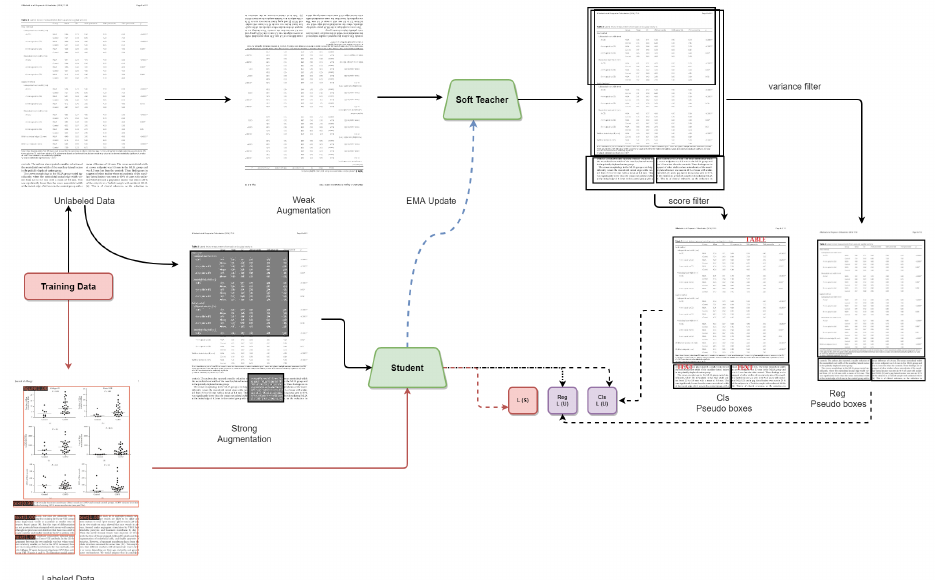
Figure 3. The image represents the Soft Teacher process: (1) The training data are divided into labeled and unlabeled data. (2) Weak and strong augmentation are applied to unlabeled data. (3) The Teacher model uses the weakly augmented data to generate two sets of pseudo boxes: one for classification and the other for bounding box regression. (4) The Student model takes both the labeled and strongly augmented data with pseudo labels to perform detection training. (5) The Teacher model is an EMA of the Student